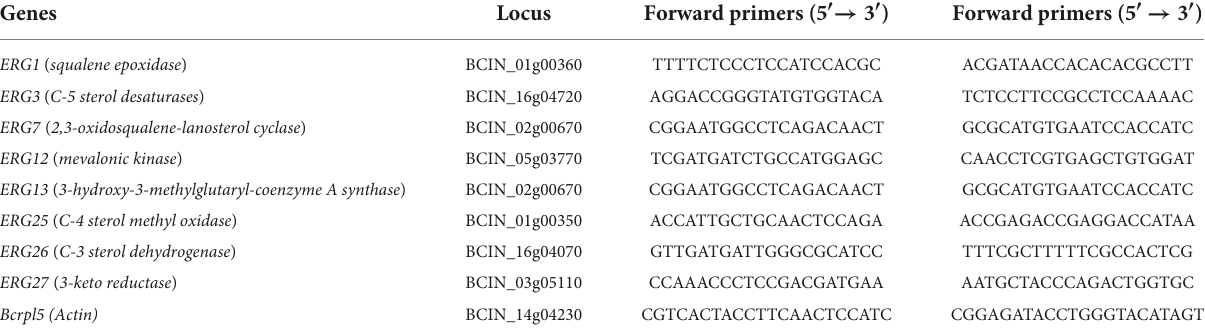
TABLE 1 Primers used in qRT-PCR analysis. Genes Locus Forward primers (5 (cid:48) → 3 (cid:48) ) Forward primers (5 (cid:48) → 3 (cid:48)